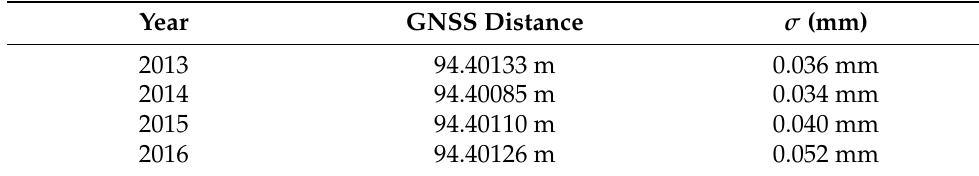
Table 6. GNSS-Based Distance Meter (GBDM) distances obtained in years 2013, 2014, 2015 and 2016, and their corresponding standard deviations.